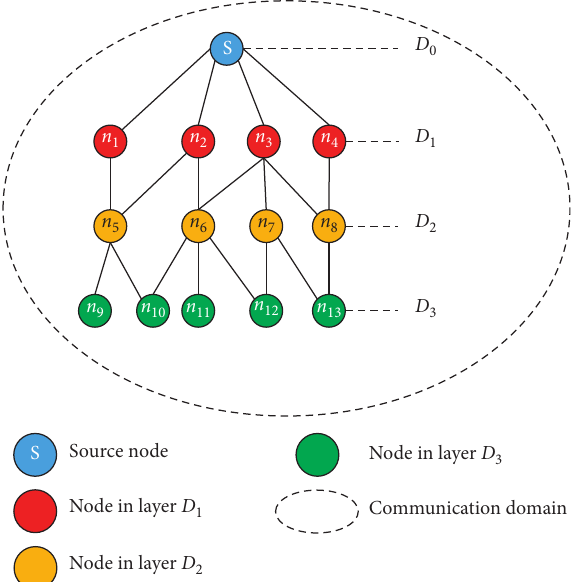
Figure 6: The layering of network